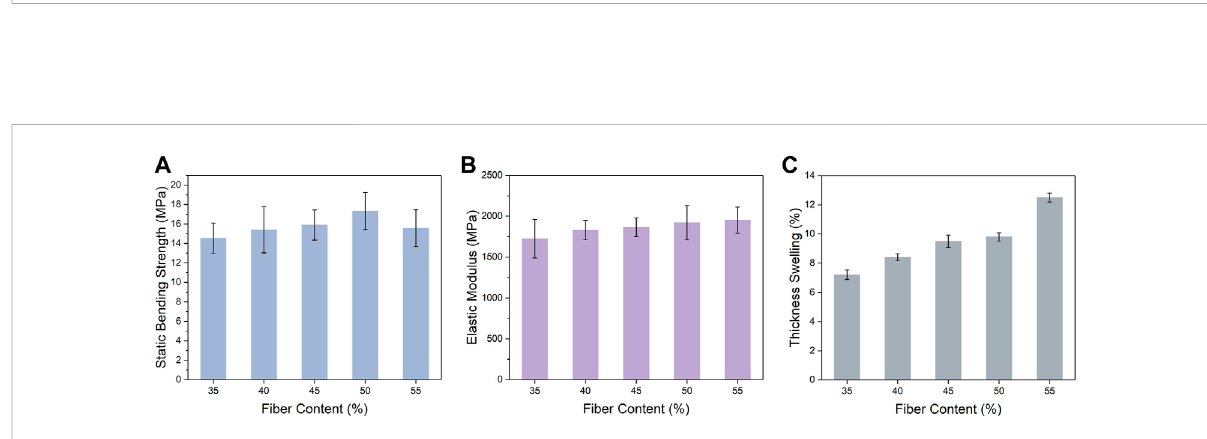
FIGURE 3 (A) Static bending strength of PF/SF. (B) Elastic modulus of PF/SF. (C) Thickness swelling of PF/SF. The hot-pressing temperature is 160 ° C and the hot-pressing time is 11